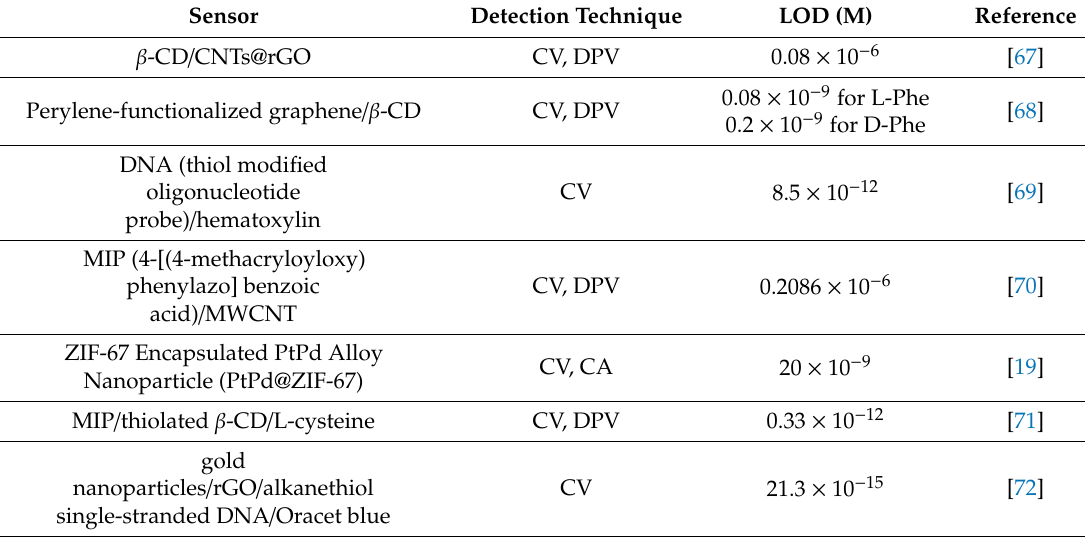
Table 2. The principal voltammetric sensors used in the detection of